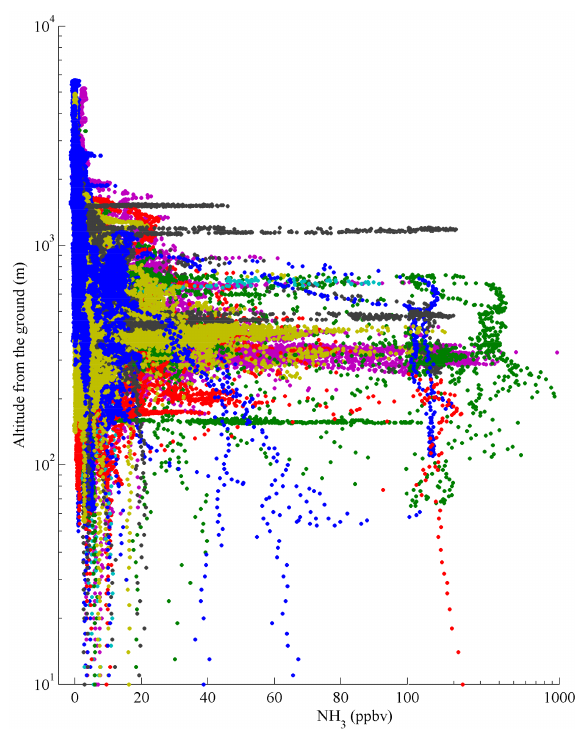
Figure 1. Vertical distribution of NH 3 airborne measurements from the NOAA WP-3D flights during the CalNex campaign in Califor- nia (2010). Each color corresponds to 1 day of